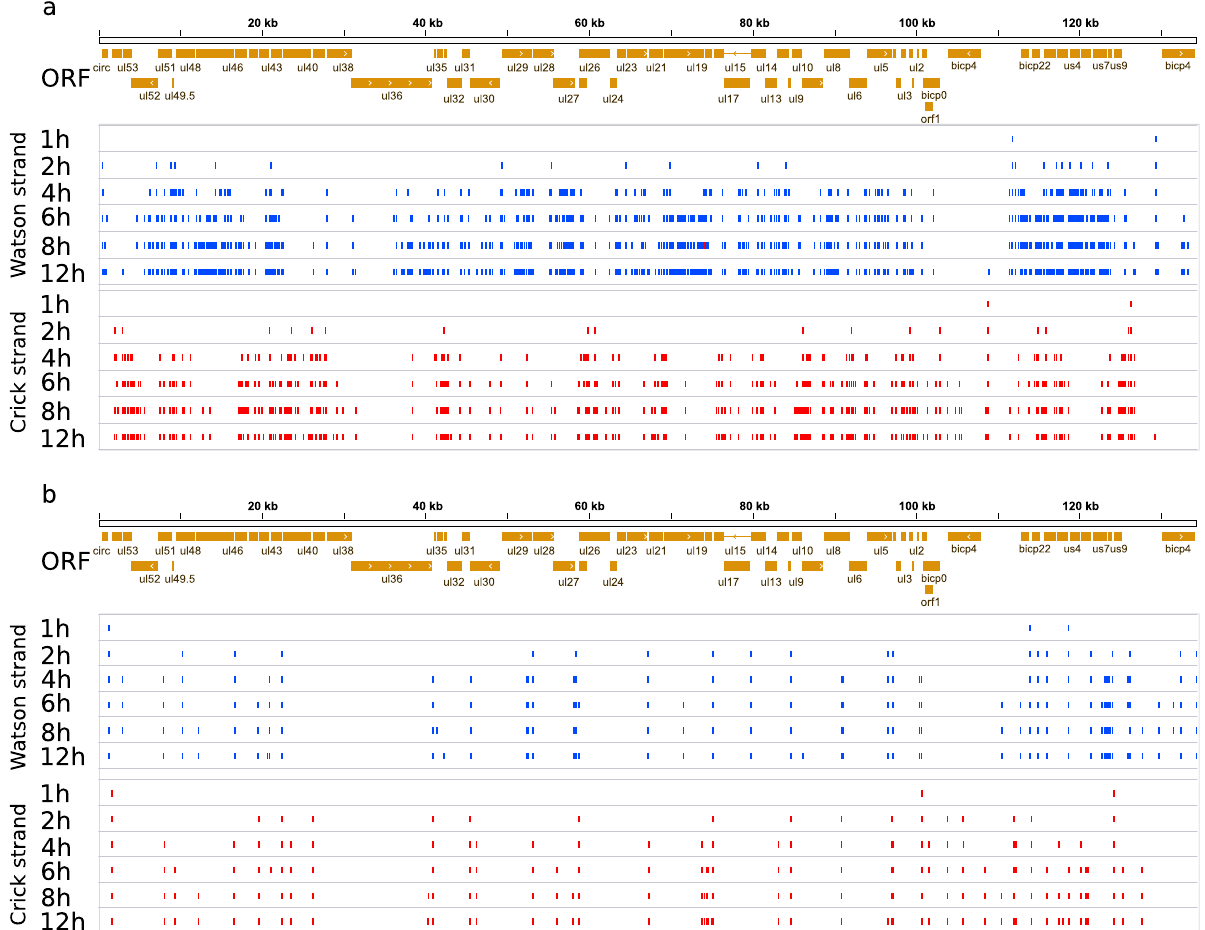
Figure 4. Genome-wide kinetics of ( a ) the TSSs and ( b ) TESs of BoHV-1. Blue dashes represent ( a ) TSSs or ( b ) TESs on the forward strand, whereas red dashes represent ( a ) TSSs or ( b ) TESs on the reverse strand. Orange rectangles illustrate the ORFs. TSSs and TESs were detected using the LoRTIA software